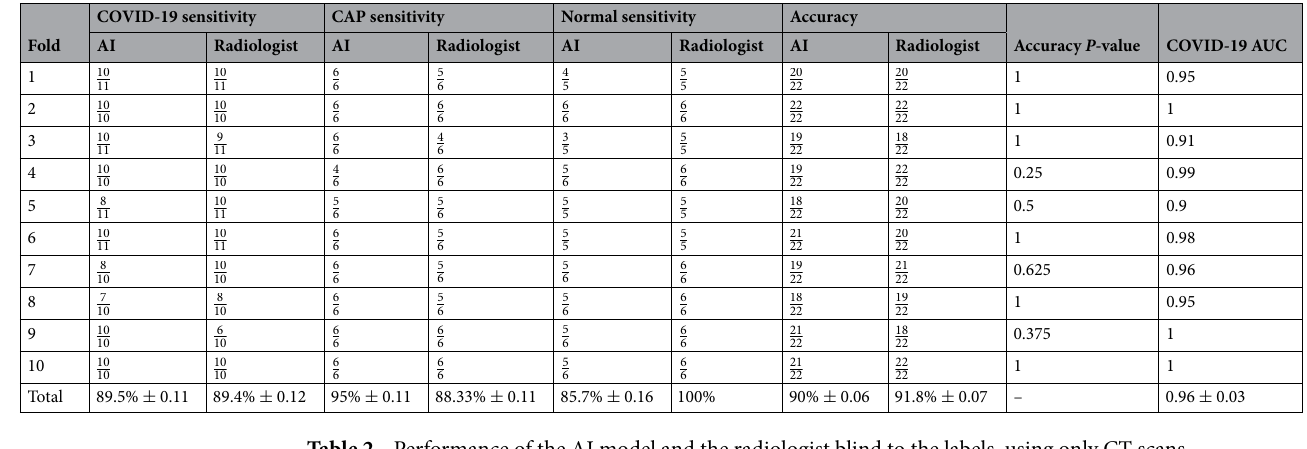
Table 2. Performance of the AI model and the radiologist blind to the labels, using only CT scans.